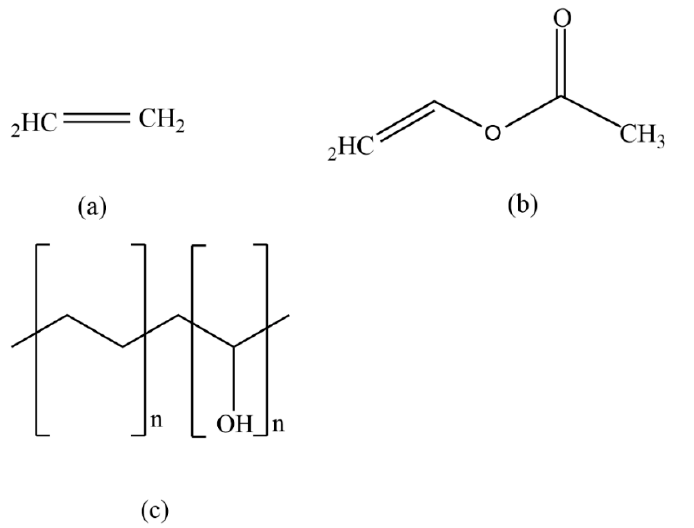
Figure 7. The structure of ethylene monomer ( a ), vinyl acetate monomer ( b ) and vinyl alcohol monomers ( c ) .